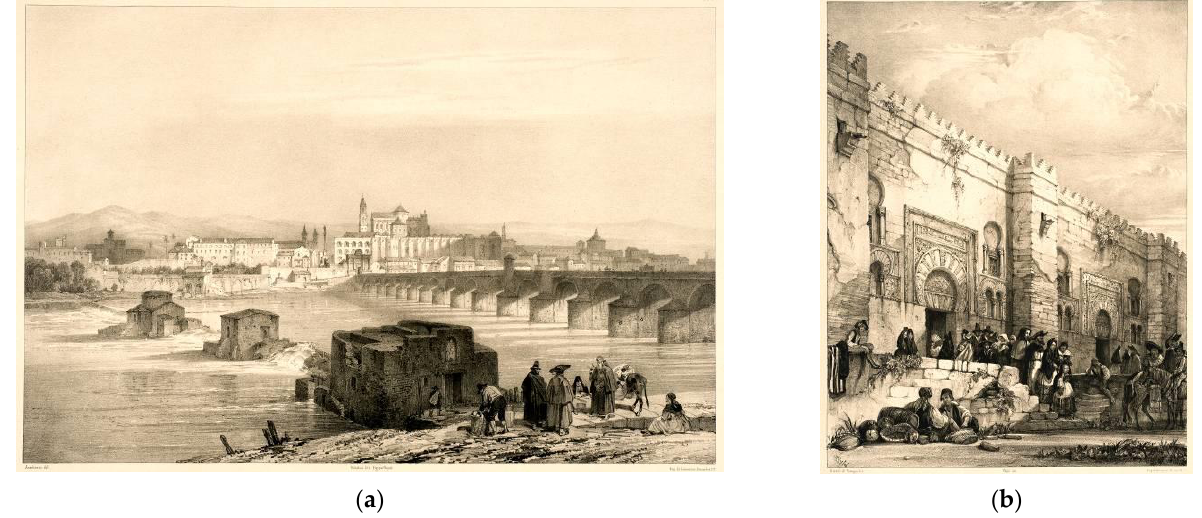
Figure 6. Mosque-Cathedral of Cordoba views: ( a ) The Guadalquivir river, the Roman bridge and the town (Bichebois, lit.; Bayot, fig.) ( b ) Lateral entrance facade (Wyld, lit.). Source: Monuments arabes et moresques de Cordoue, 1839.